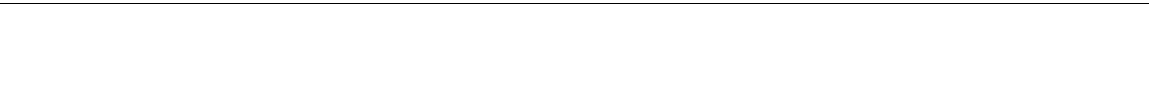
FIGURE 5 | Population differentiation in C. caespito sa according to a DAPC analysis of (A) all populations or (B) only the western Mediterranean populations.